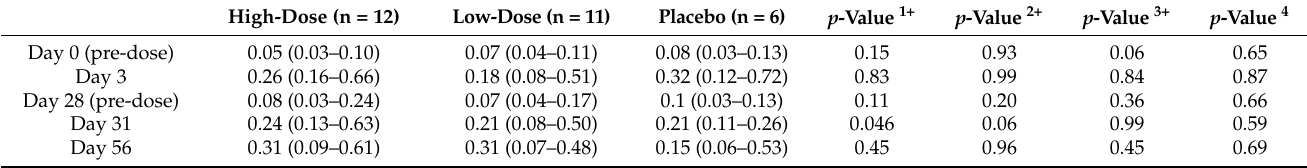
Table 4. Summary of saliva total Ig response.